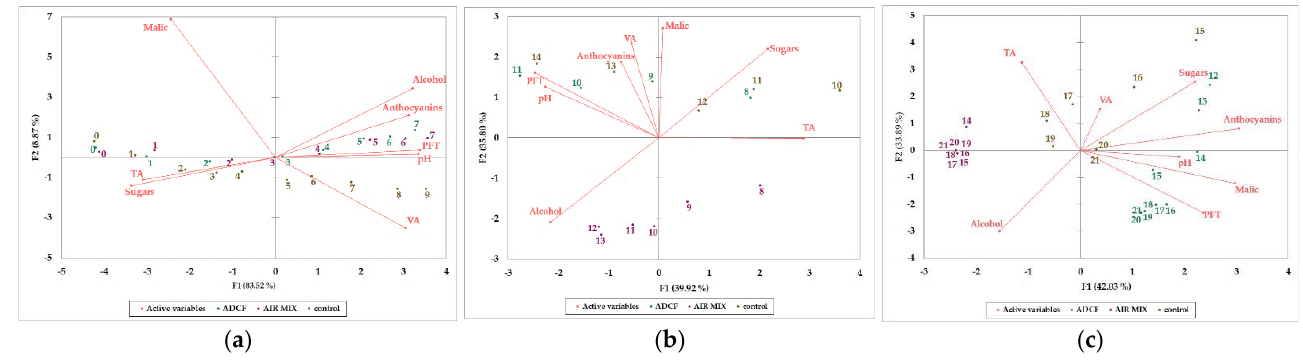
Figure 4. Principal compounds analysis biplot of the three-fermentation process phases using three different maceration techniques (average of the data of 2020 and 2021 year). TA, titratable acidity; VA, volatile acidity; PFT, total polyphenols. The numbers indicate the days of fermentation/maceration.